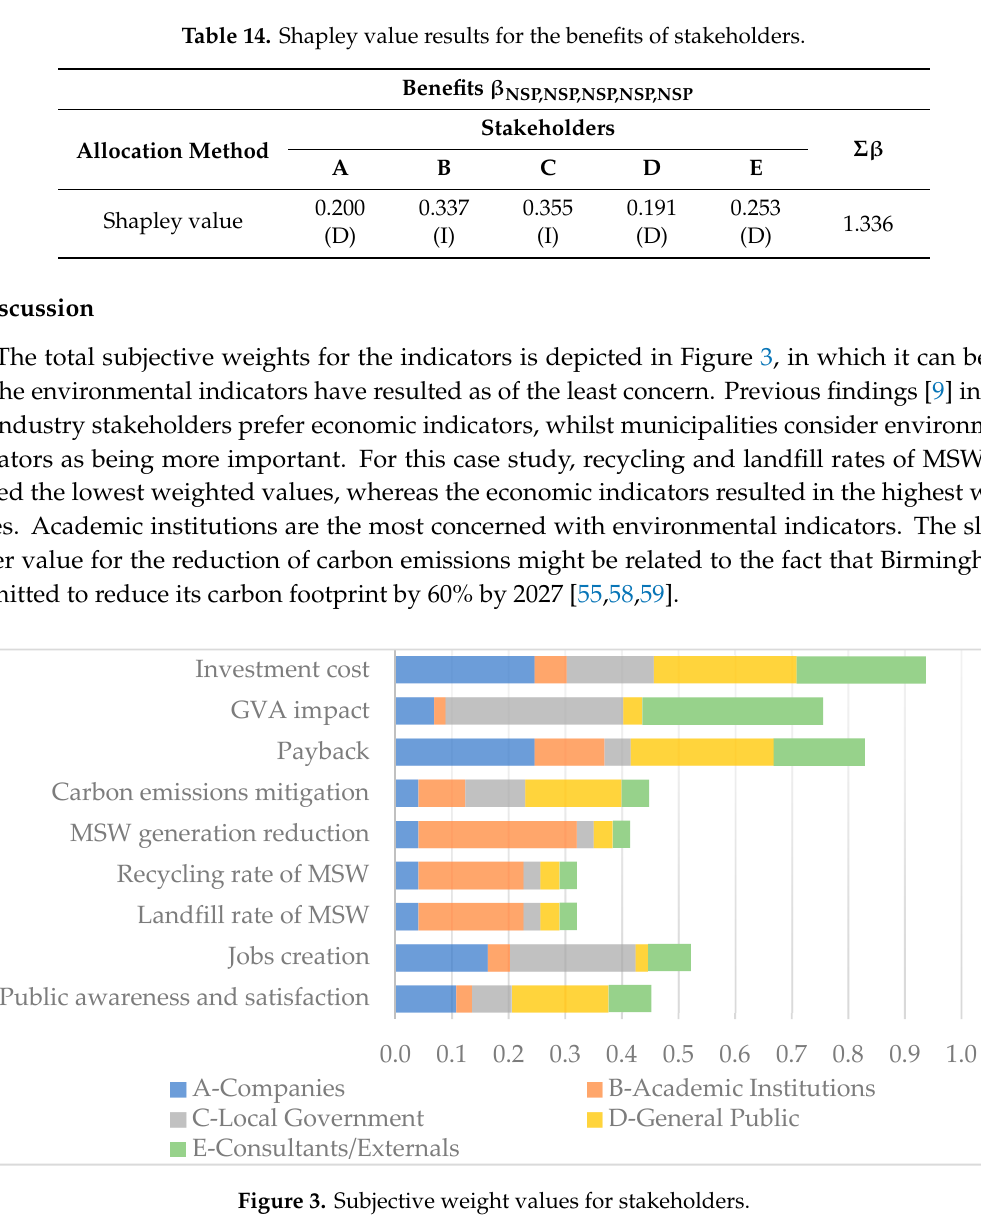
Figure 4. Objective weight values for scenarios. NSP also resulted as the most preferred scenario for all stakeholders (Figure 5). This is in line with previous observations where 70% or their interviewed stakeholders ranked highest the most sustainable performing composting plant site alternative [15]. However, the second most preferred scenario varied between stakeholders. For example: stakeholders A (Companies) and D (General Public) ranked MF, FW and PR in second, third and fourth places, respectively. This means that they prefer a business-as-usual and a breakdown scenario over a strong policy implementation. In contrast, stakeholders B, C and E ranked PR, MF and FW in decreasing order. This suggested, before